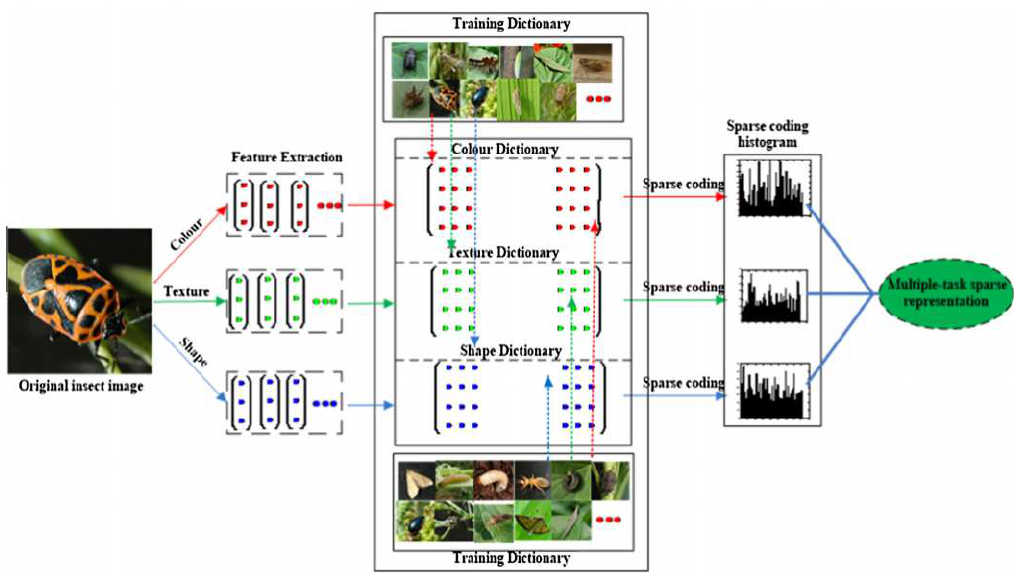
Figure 5. Multiple task sparse representation for Insect appearance [11].